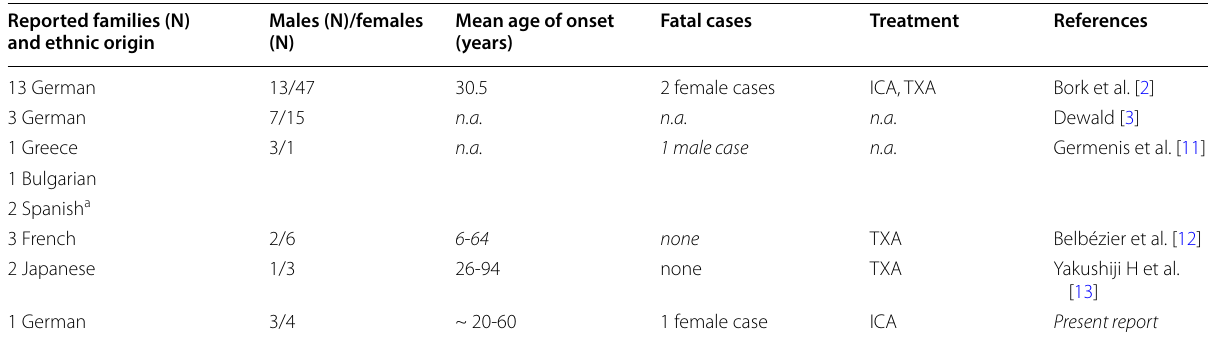
Table 1 Overview of reported cases with HAE-nC1-INH and the plasminogen mutation PLG:p.Lys330Glu mutation